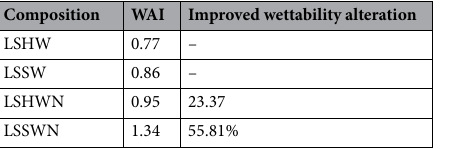
Table 16. Results of wettability alteration for different LSW compositions with and without silica